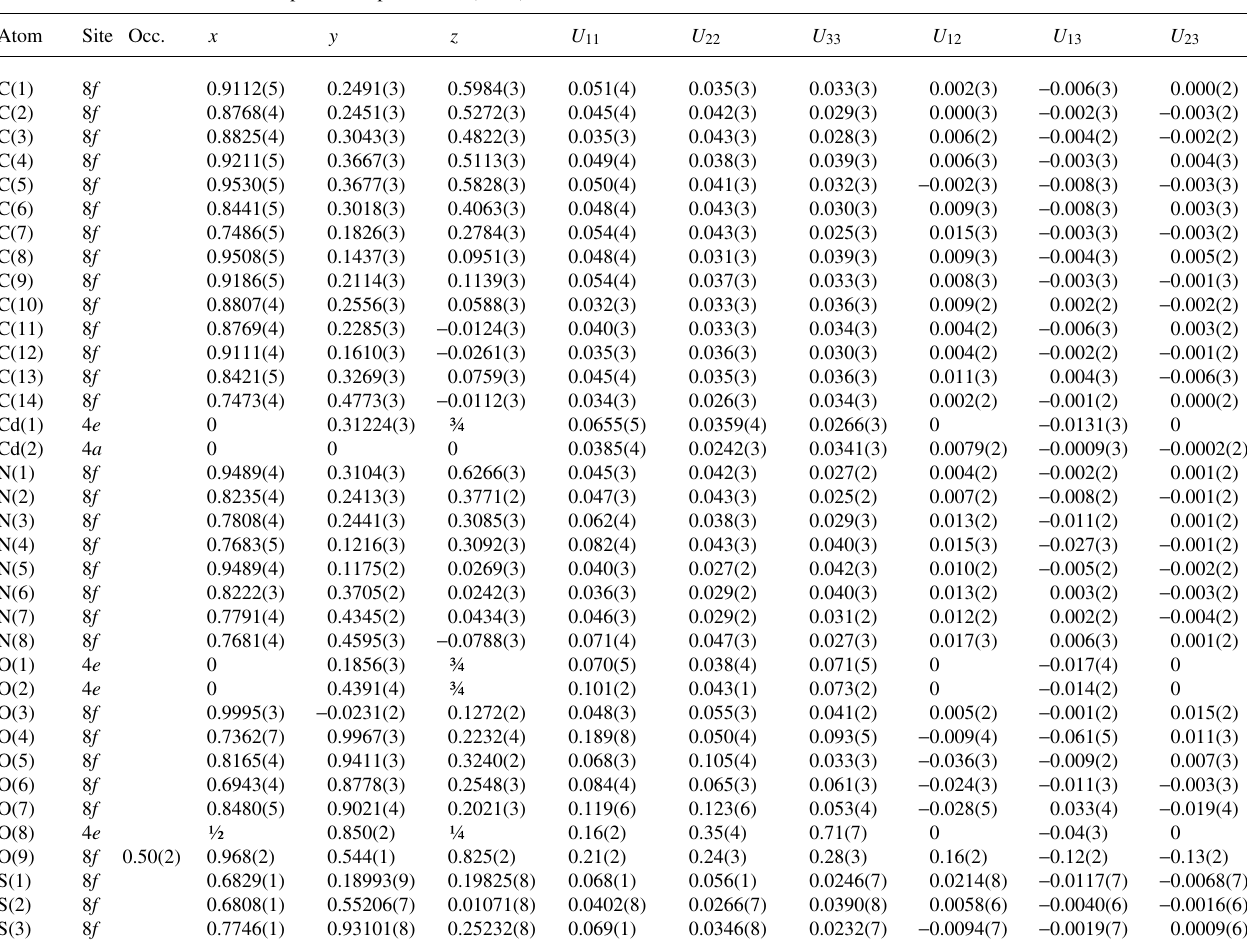
Table 3. Atomic coordinates and displacement parameters (in Å 2 ) .